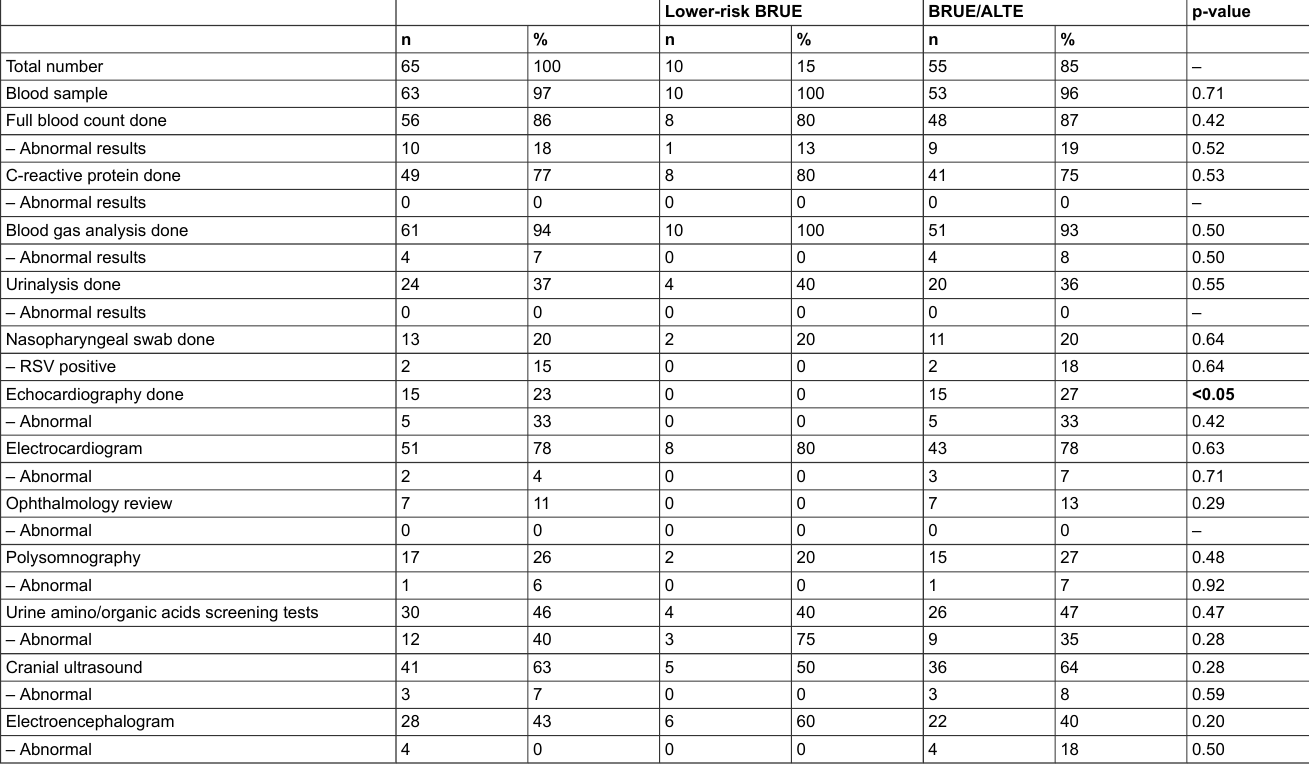
Table 3: Comparison of investigations of lower-risk BRUE and BRUE/ALTE